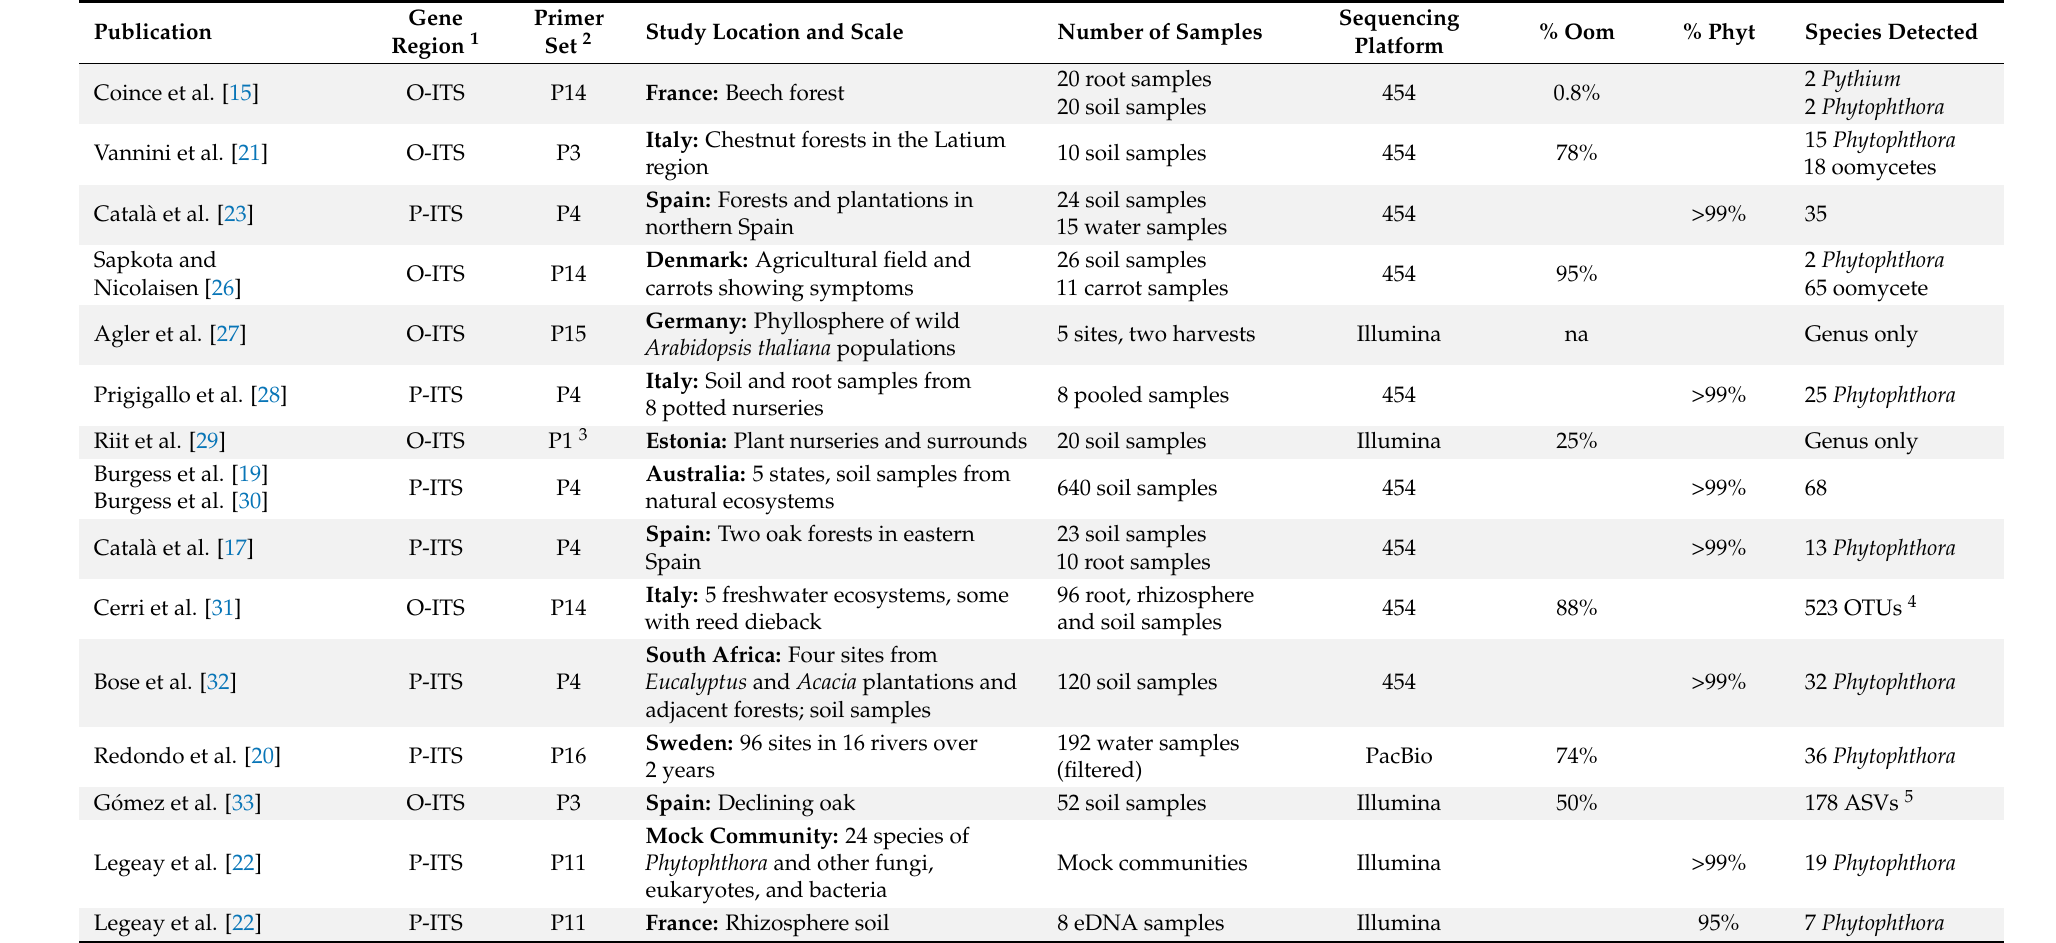
Table 1. A summary of metabarcoding studies in chronological order conducted to determine diversity or community dynamics of